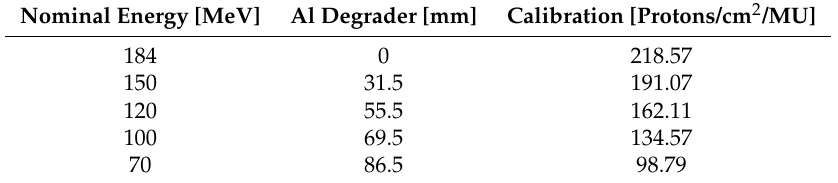
Table 1. Specification of the high energies at the DUT position (MeV) and resulting calibration factor (protons per cm 2 per monitor unit (MU) ) for the desired configuration and the amount of degrader material (mm Aluminum) that needs to be used.